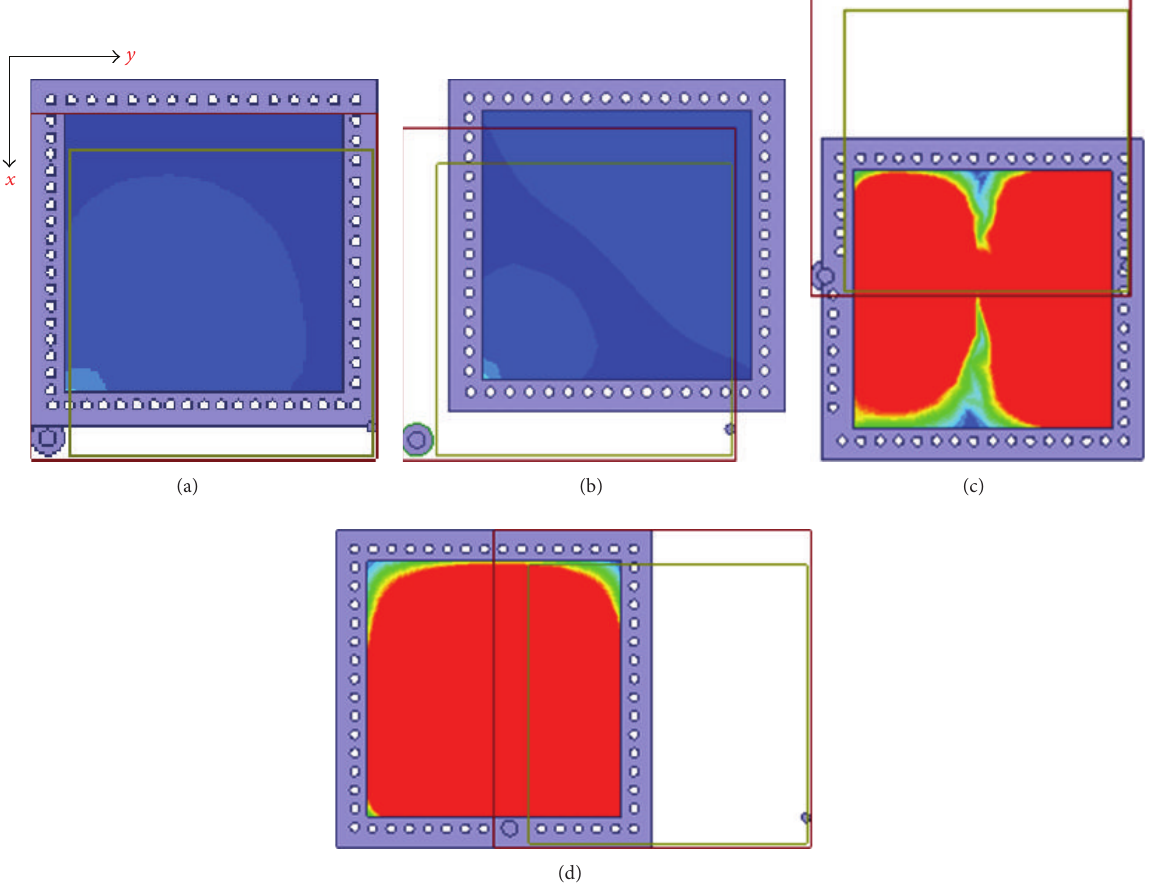
Figure 7: Electric field intensity distribution in the package cavity, (a) model of the package near the feed, (b) model of the package offset 2 mm from the feed along 𝑥 -axis and 𝑦 -axis, respectively, (c) model of the package offset 5 mm from the feed along 𝑥 -axis, and (d) model of the package offset 7mm from the feed along 𝑦